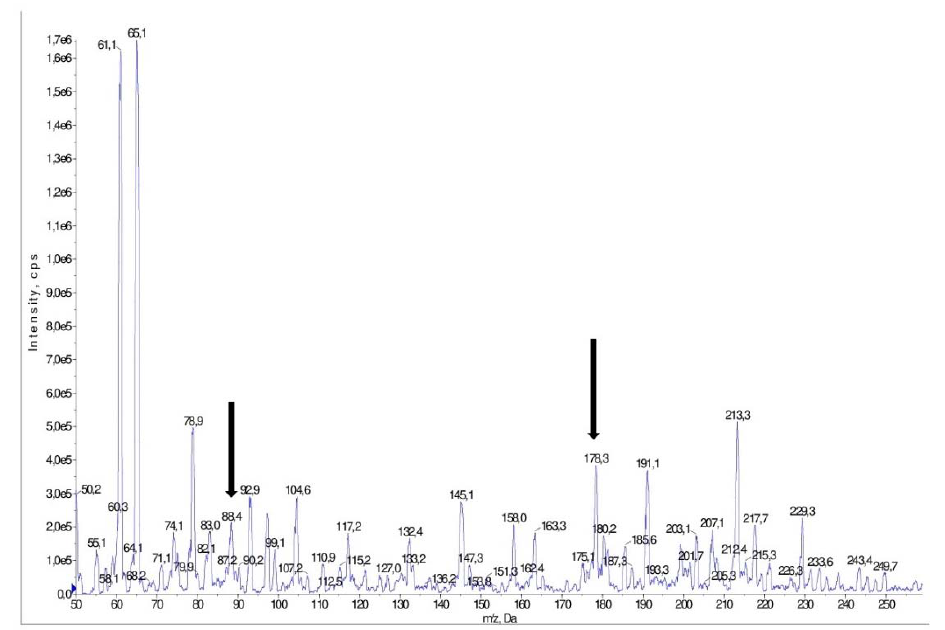
Figure 4. Mass spectrum of a pick obtained for a sample of Harna´s collected in June. The pick was obtained for S -allyl-L-cysteine sulfoxide ( m / z = 178 / 88). The ion pairs, which was identified as S -allyl-L-cysteine sulfoxid, is marked with arrows.